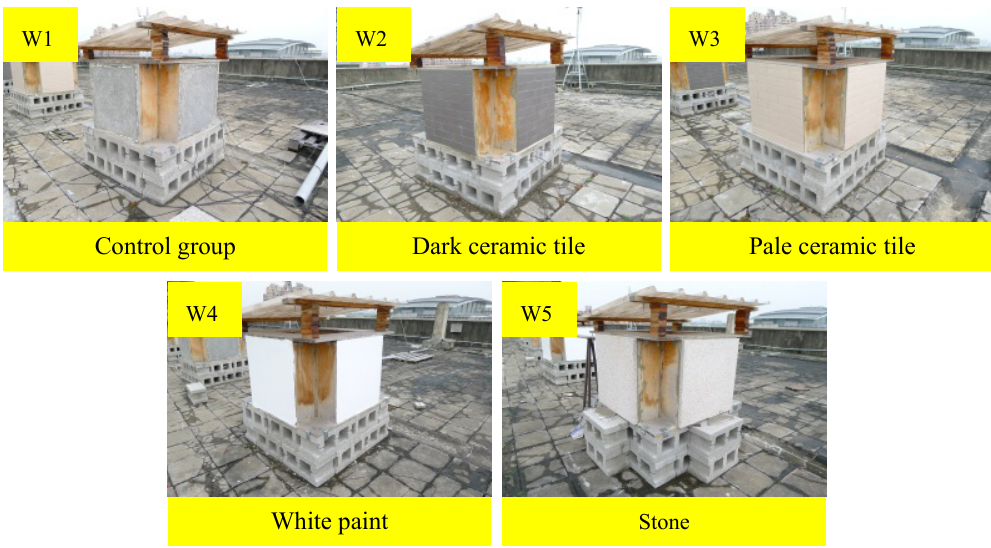
Figure 8. Simulated wall insulation material samples (dark and pale ceramic tile, white paint, and